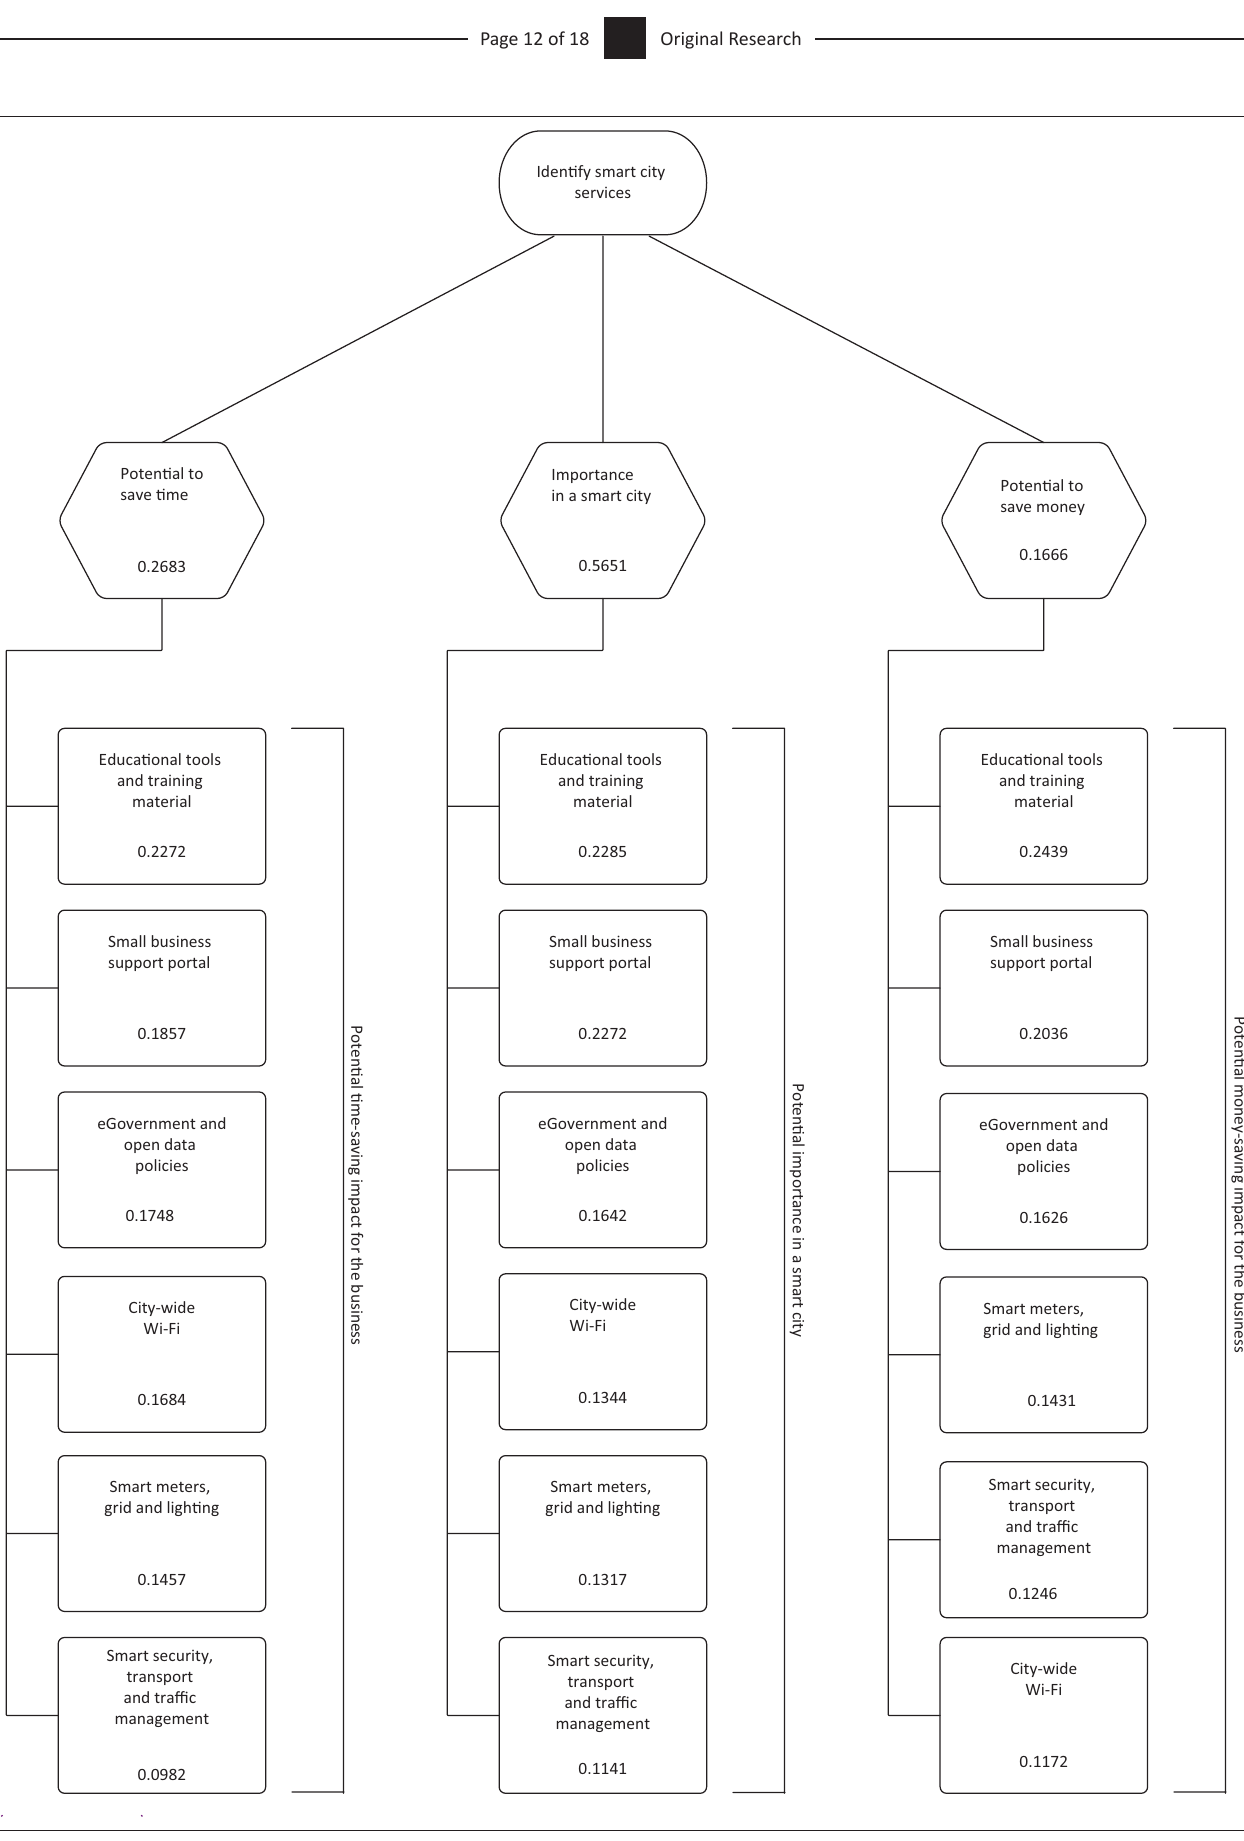
FIGURE 10: Relative value of smart city